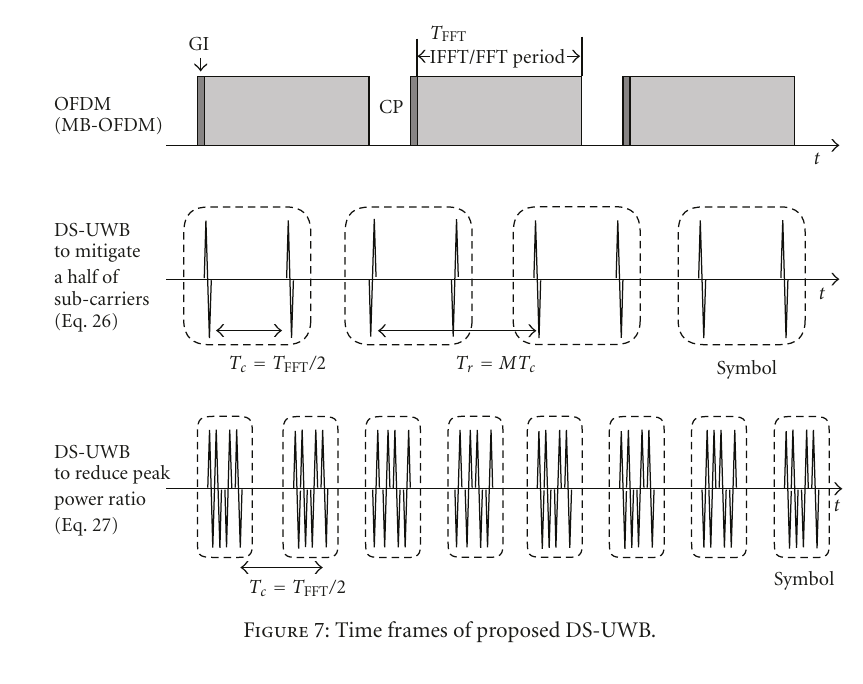
Figure 7: Time frames of proposed